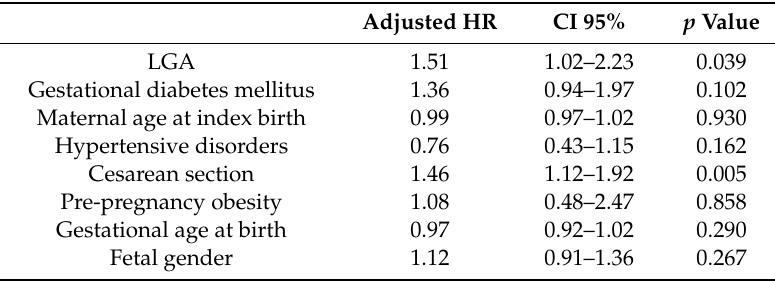
Table 3. The Cox multivariable regression model to evaluate the risk of childhood malignancies in children who were born LGA while controlling for confounders.